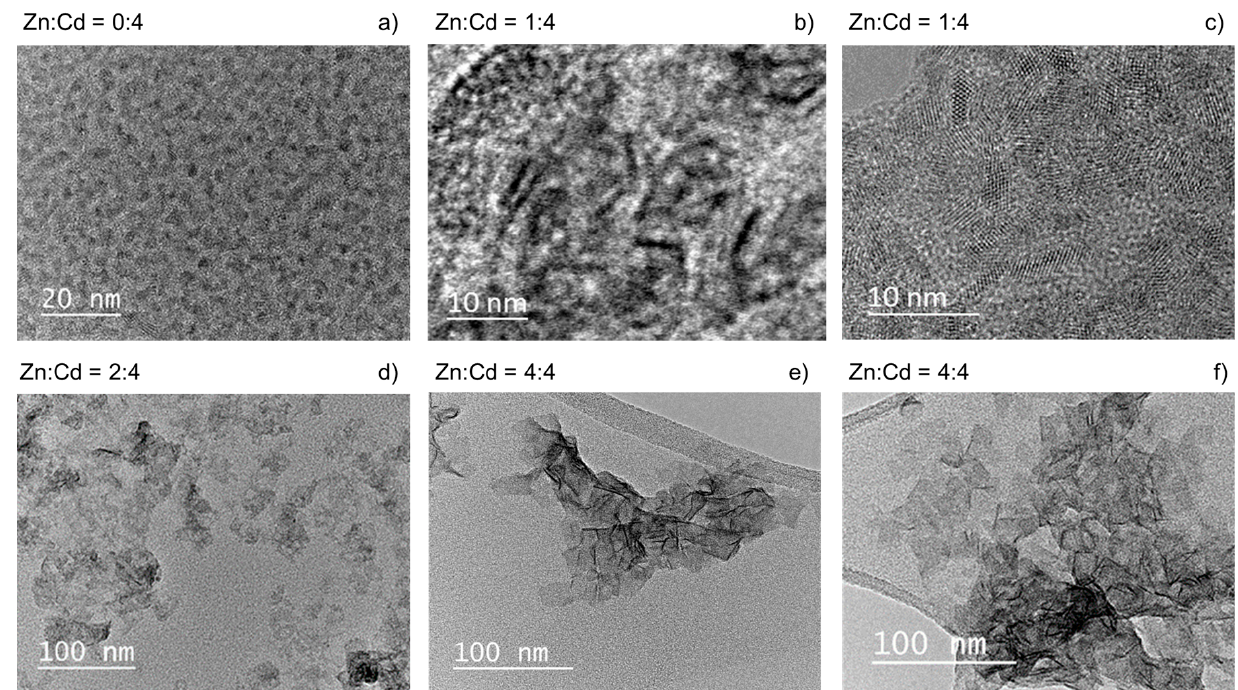
Figure 3. TEM images of four CdS nanocrystals obtained with different Zn(Ac) 2 concentrations. The Zn:Cd ratio was ( a ) 0:4, ( b , c ) 1:4, ( d ) 2:4, and ( e , f ) 4:4. The reaction temperature for all samples was 180 ◦ C, and the reaction time—60